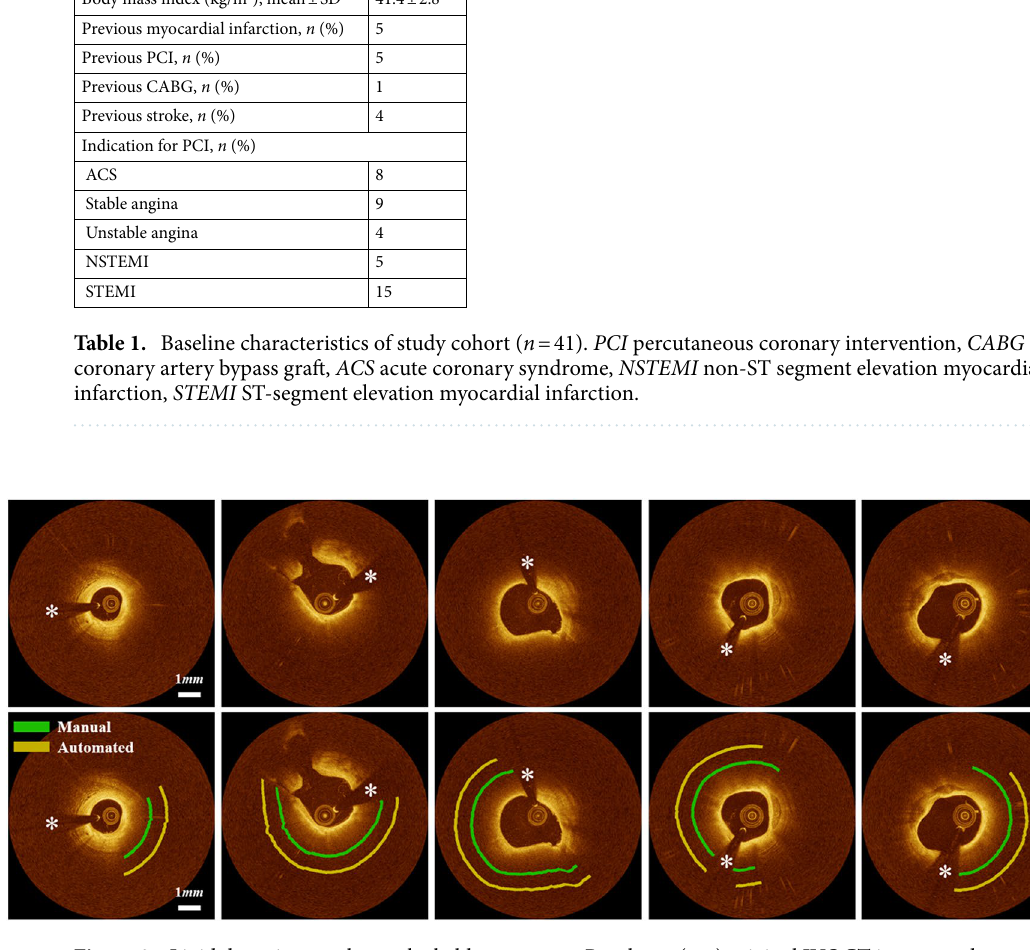
Figure 3. Lipid detection results on the held-out test set. Panels are (top) original IVOCT images and (bottom) manual and automated results. Green is the manual annotation, and yellow is the predicted result. Please understand that these markups show the angle region of lipidic lesions. The white asterisk (*) indicates the guidewire